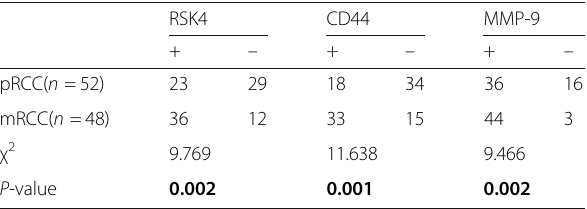
Table 1 χ 2 test of the expression of RSK4, CD44 and MMP-9 in pRCCs and mRCCs